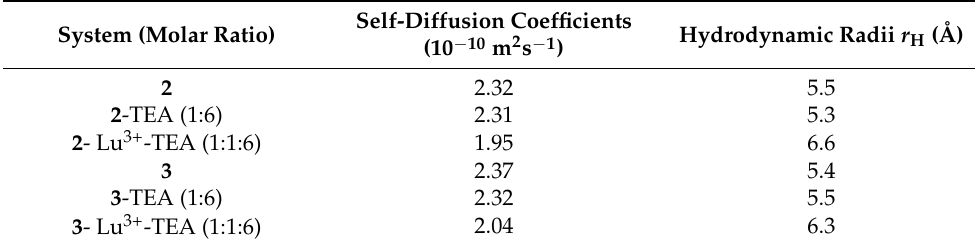
Table 1. Self-diffusion constants, hydrodynamic radii for ligands H 4 L( 2 , 3 ) (2.5 mM) in DMSO- d 6 solutions before and after addition of Lu 3+ (2.5 mM) and TEA (15 mM) at 303 K.